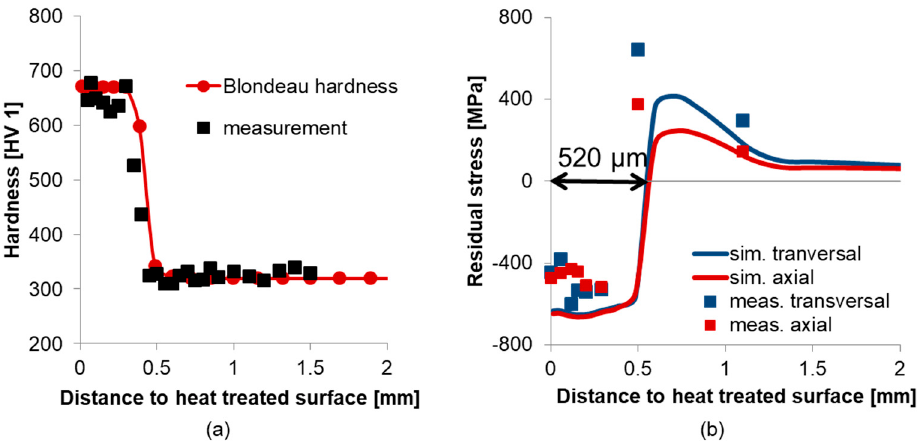
(simulation), fiber core diameter 600 µm.